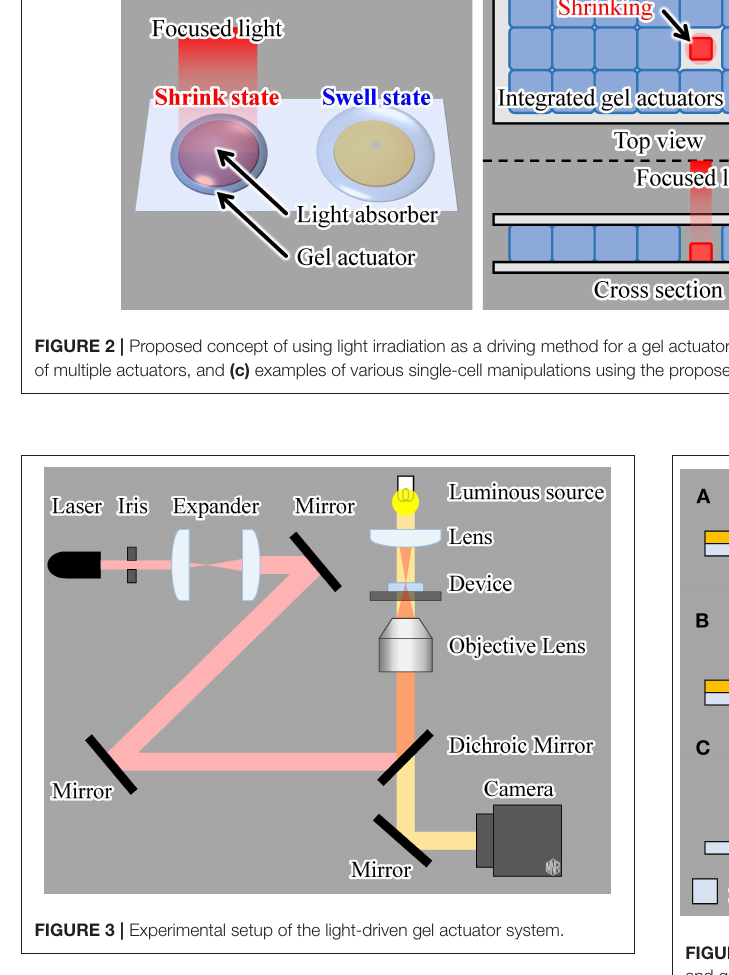
FIGURE 4 | Fabrication process of the gel microactuator. (A) Chromium (Cr) and gold (Au) or Cr are deposited on glass substrate by using vapor deposition. (B) OFPR (OFPR-800, Tokyo Ohka Kogyo Co. Ltd., Kanagawa, Japan) is patterned on a Cr/Au layer as an etching mask. (C) Cr/Au or Cr layers are etched. (D) OFPR is removed. (E) PNIPAAm is spin coated. (F) PNIPAAm is